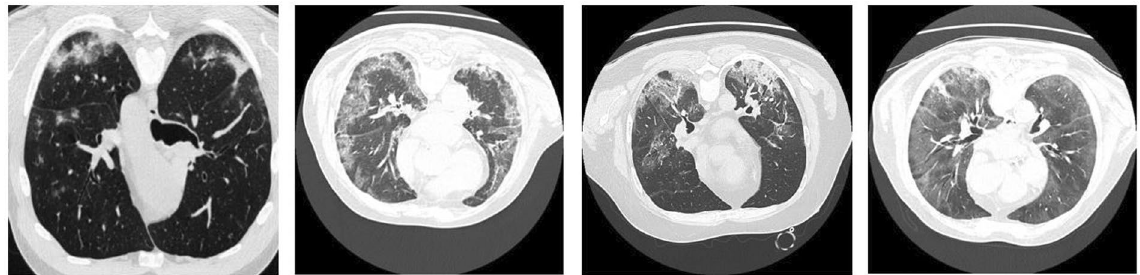
Figure 1. Samples and corresponding labels, where the ground-glass, consolidation, and pleural effusion are marked in dark gray, bright gray, and white,